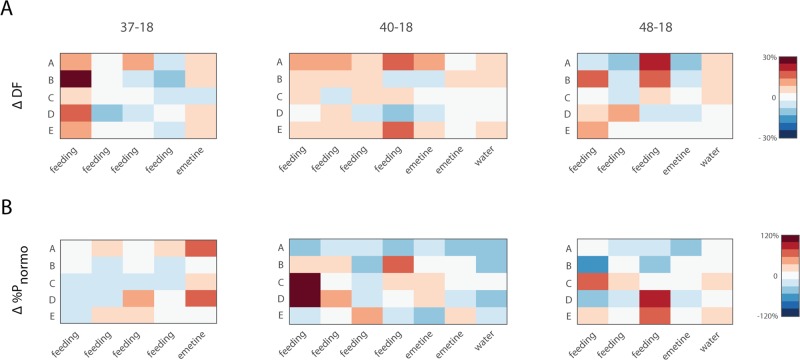
Change in DF and Pnorm during gastric distension.A) Heatmap of the change in DF and B) percentage of total power in the normogastric range across multiple days of testing for subjects 37–18, 40–18 and 48–18 (columns).